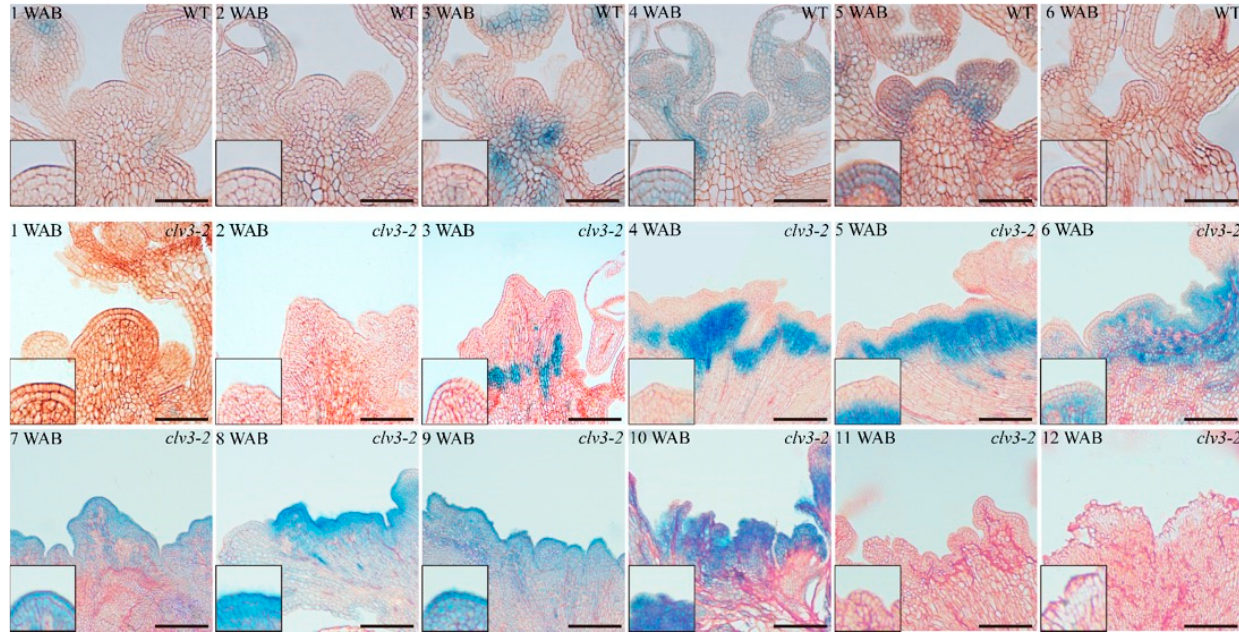
Figure 5. The spatial-temporal expression patterns of ORE1 in WT and clv3-2 mutants. The magnified images at the bottom left corner indicate the ORE1 expression signals (blue color) in the stem cell layers. Scale bars: 50 μ m in WT and 100 μ m in clv3-2 .